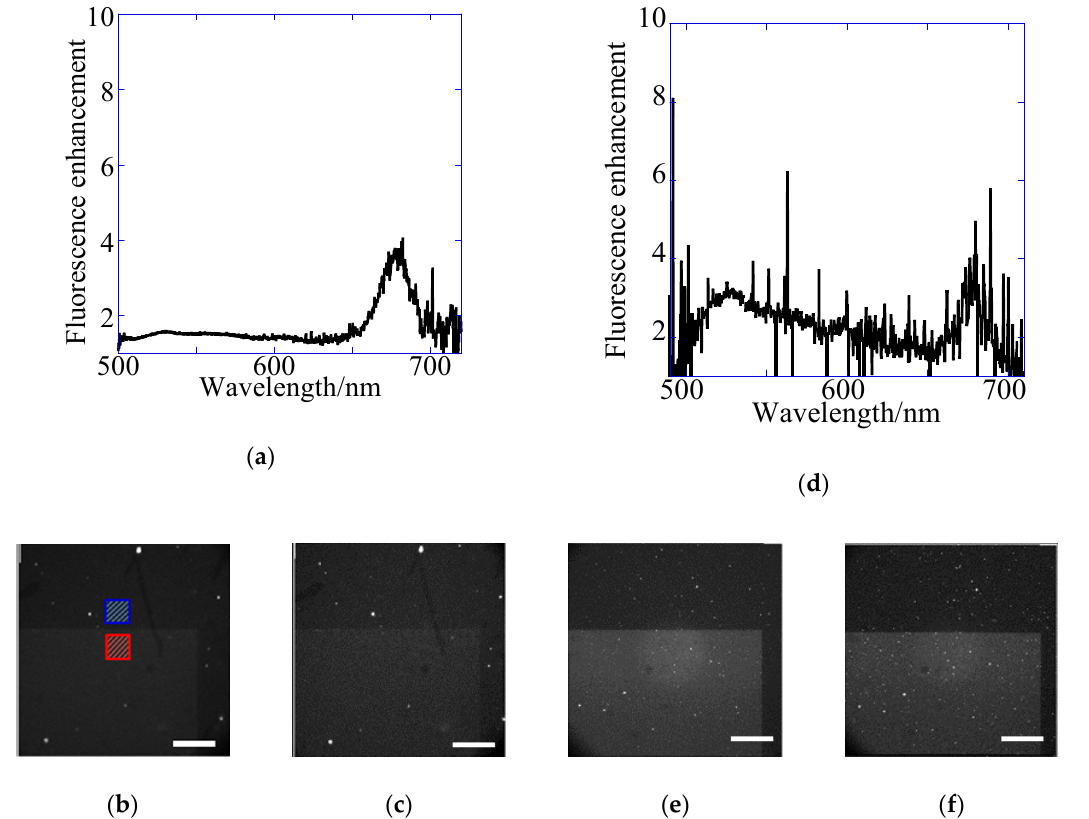
Figure 5. ( a , d ) fluorescence spectra and images of yellow–green (YG) fluorescence detected with ( b , e ) emGFP (495–540 nm) and ( c , f ) emCy3 (570–615 nm) filters for the 1D plasmonic chip on epi-fluorescence ( a – c ) and transmitted-light systems ( d – f ). The fluorescence enhancement was evaluated by the ratio of the fluorescence intensity in region of interest (ROI) for the grating area (red square) to that for flat metal area (blue square) in fluorescence images as shown in ( b ).